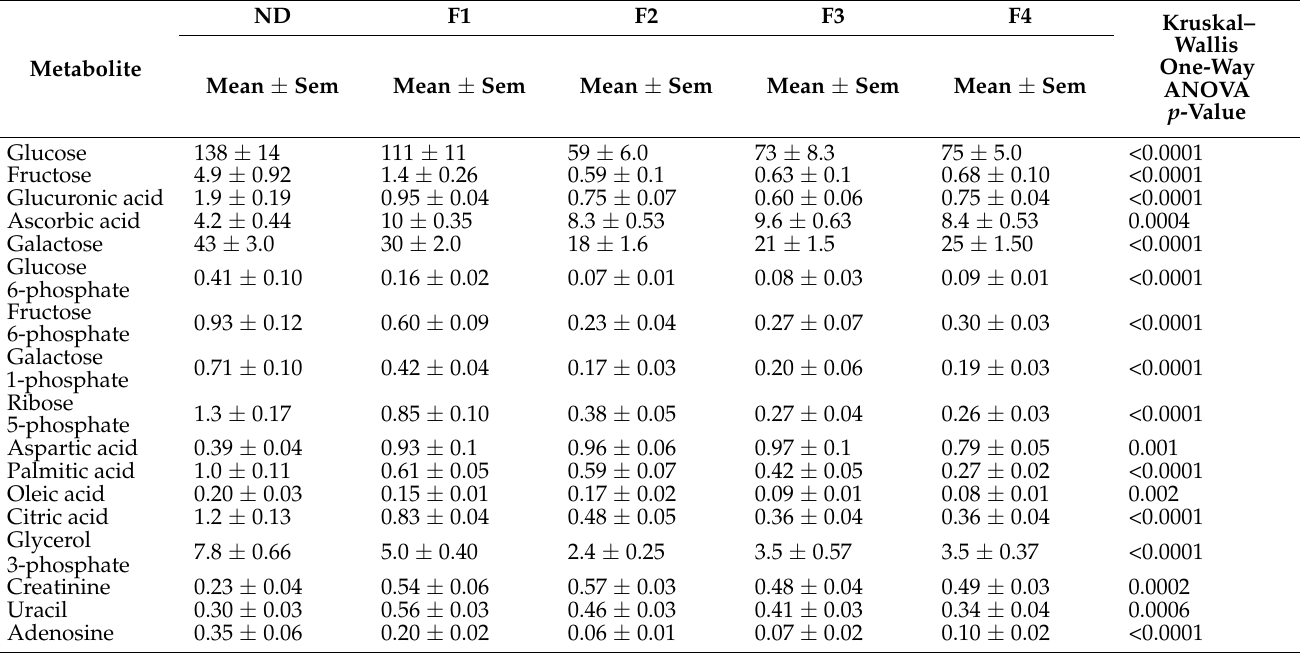
Table 3. Hepatic metabolite changes in a HF-CDAA model of